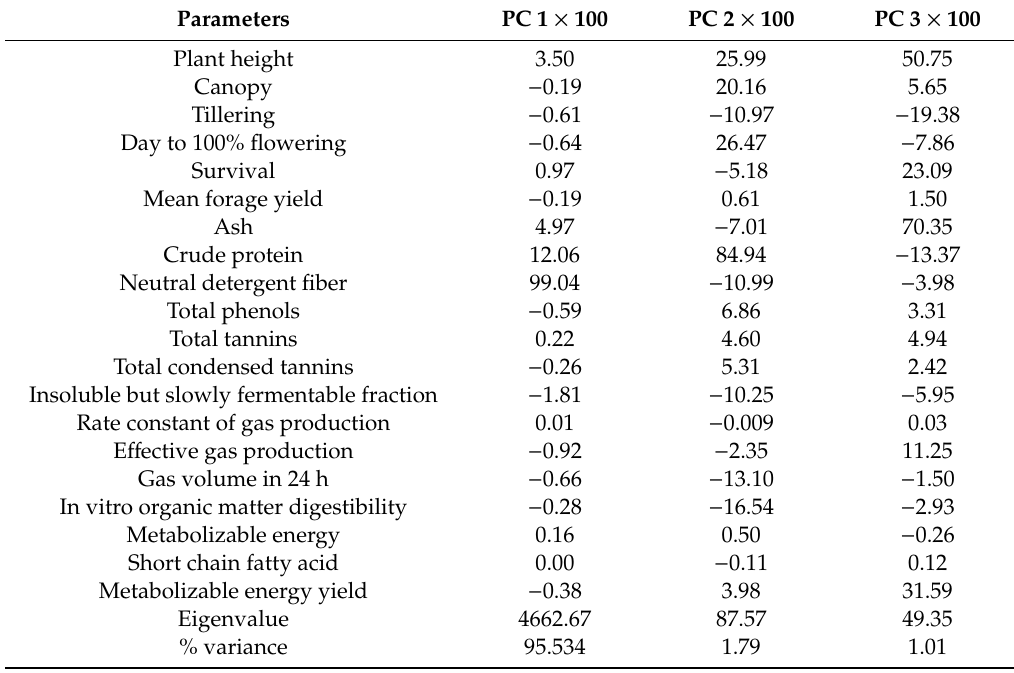
Table 2. Principal component (PC) loadings of chemical composition, growth parameters, forage yield, in vitro gas production and digestibility for di ff erent forages of S. scabra accessions.